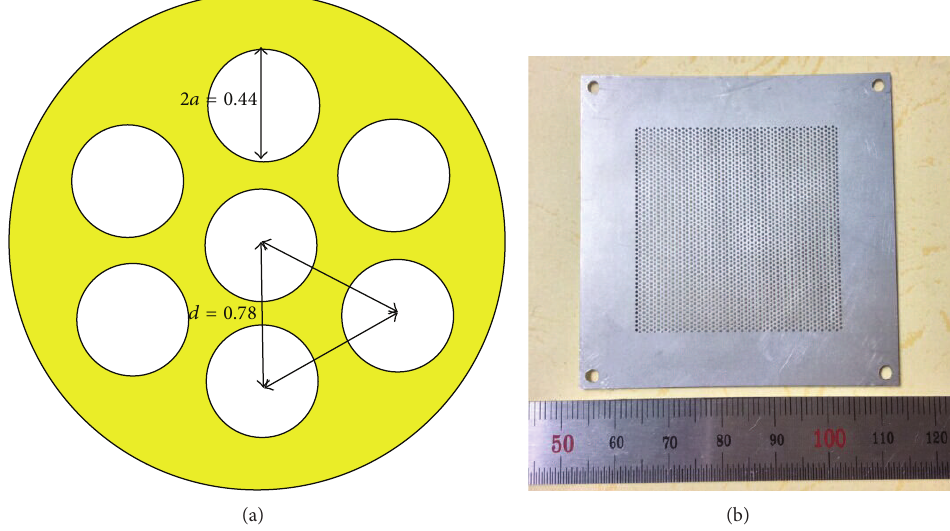
Figure 7: Designed and fabricated FSS: (a) unit element geometry; (b) manufactured prototype.